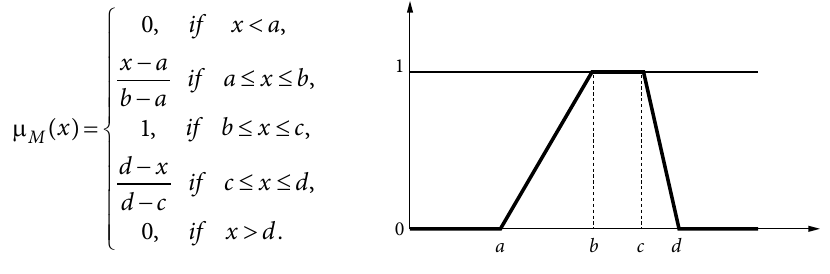
Fig. 1. Trapezoidal fuzzy numbers